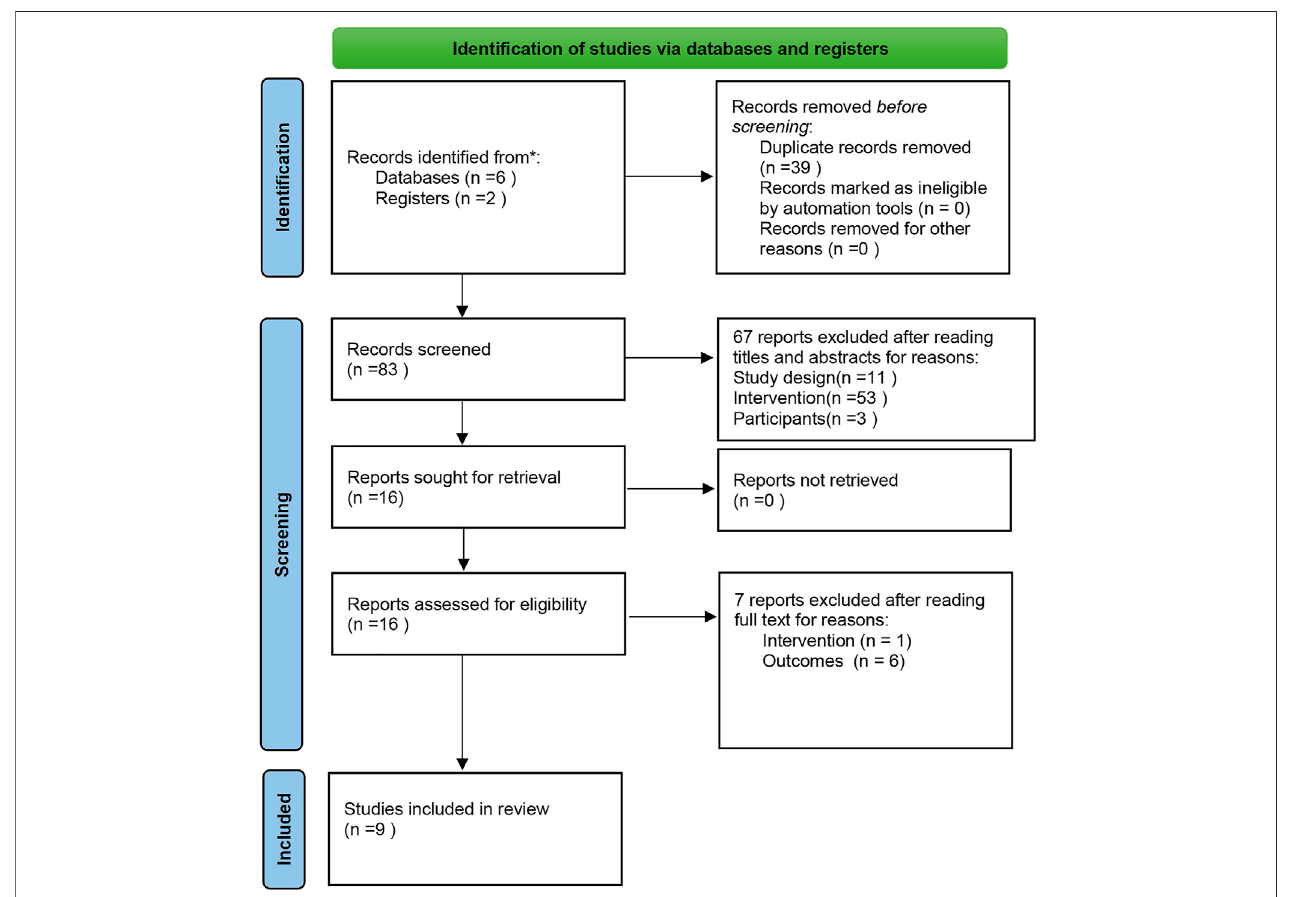
FIGURE 1 | A PRISMA fl ow diagram of the literature screening and selection process.